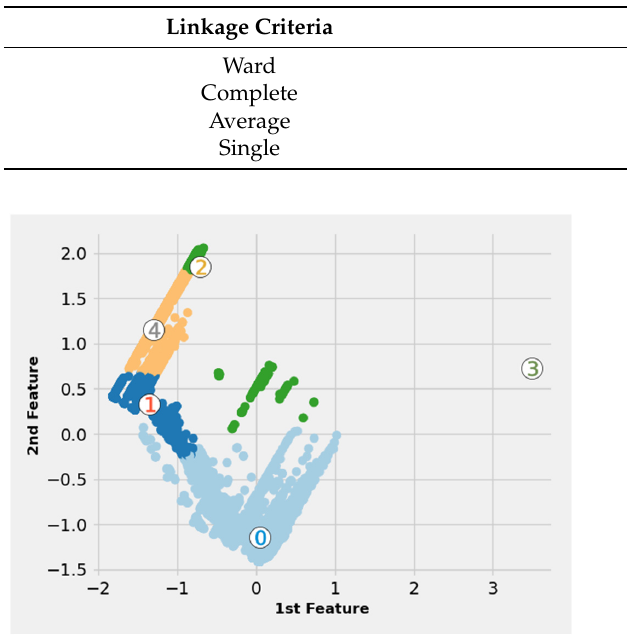
Figure 7. Hierarchical clustering results of the IEEE-24 bus contingencies in the feature domain